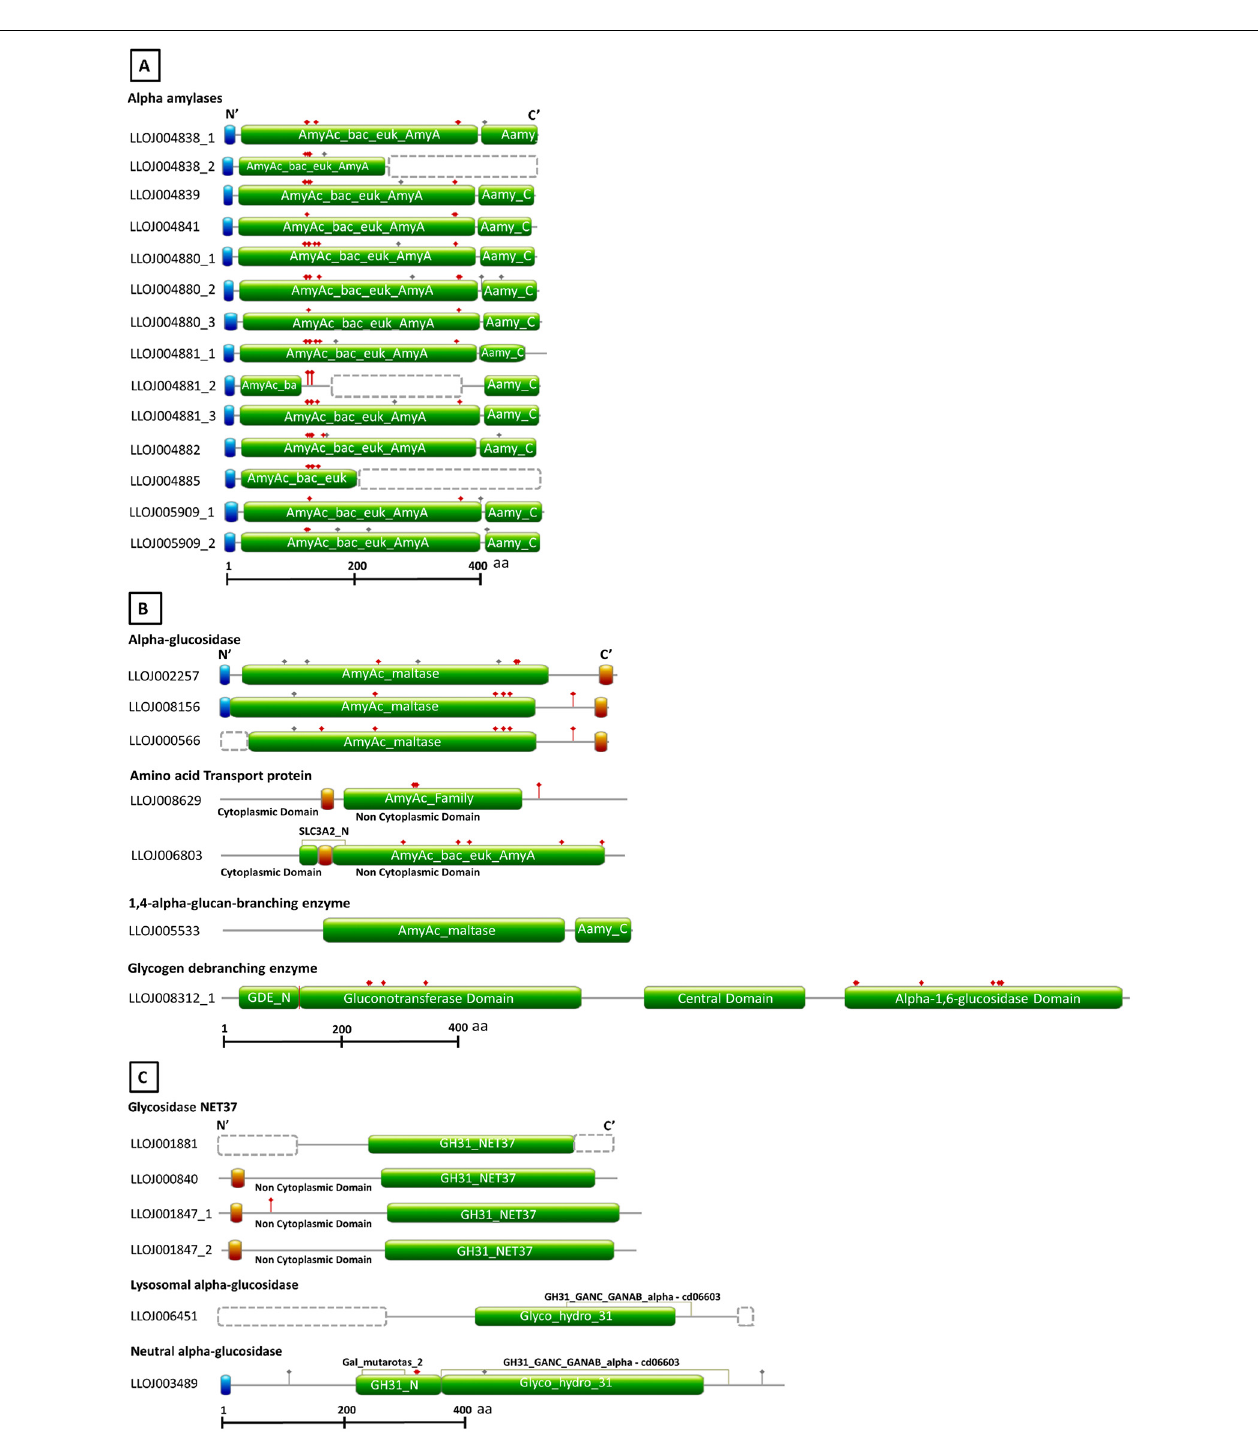
FIGURE 1 | Schematic diagram of the domain architecture of L. longipalpis proteins from GH13 and GH31. Sequences were retrieved from Vector Base (Jacobina strain, LlonJ1.4 geneset, June 2017). Signal peptide, transmembrane domains, and domains used to identify the different catalytic activities are boxed with the blue, red and green background, respectively. Gray and red dots above structures represent the N- and O- glycosylation sites. Dotted boxes represent missing parts in incomplete protein sequences. For incomplete protein structures, models were designed based on homology with orthologous protein sequences. The structures were outlined using as reference the best hits obtained with Blastp (refseq_protein) and Conserved Domain Database. (A) Domain composition of GH13 α -amylases. (B) Domain composition of GH13 α -glucosidases, amino acid transport proteins, 1,4- α -glucan-branching-enzyme, and glycogen debranching enzyme. (C) Domain composition of GH31 glycosidases NET37, neutral α -glucosidase, and lysosomal α -glucosidase.